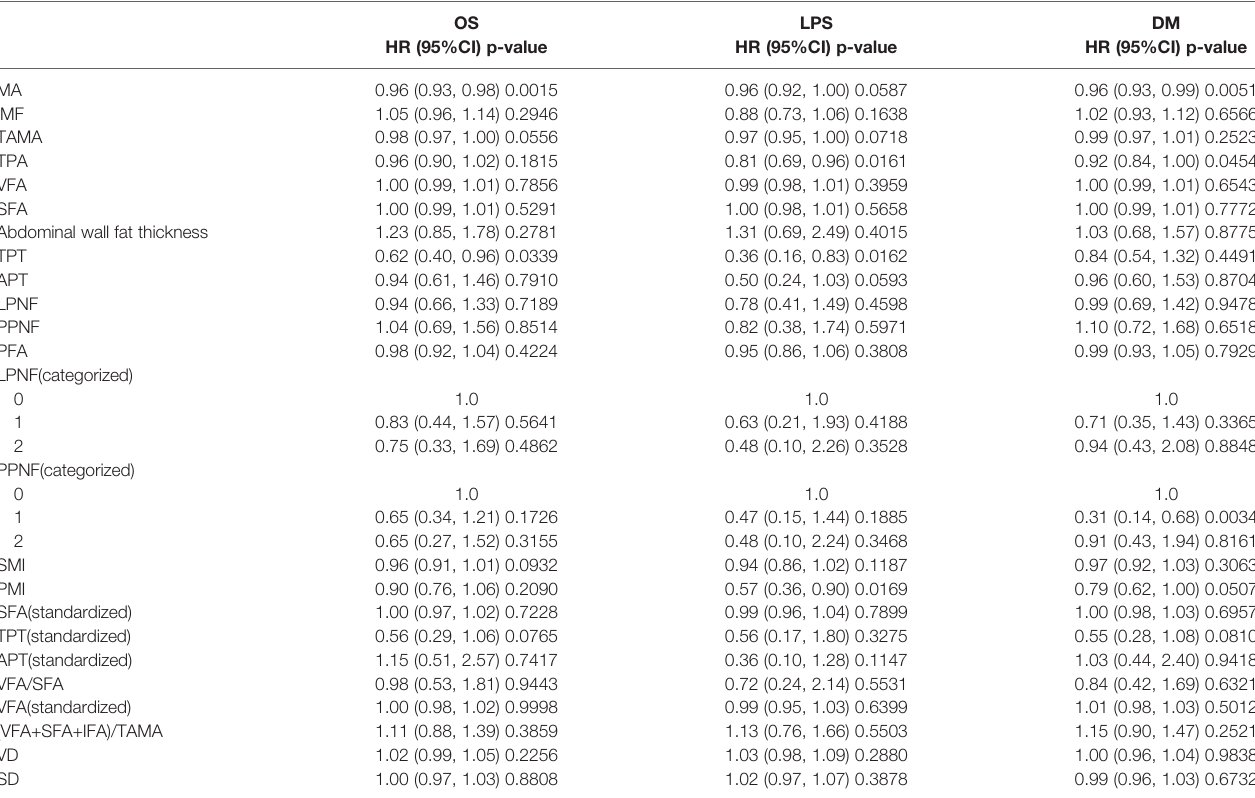
TABLE 2 | Univariate cox proportional hazard analysis for risk factors of patients ’